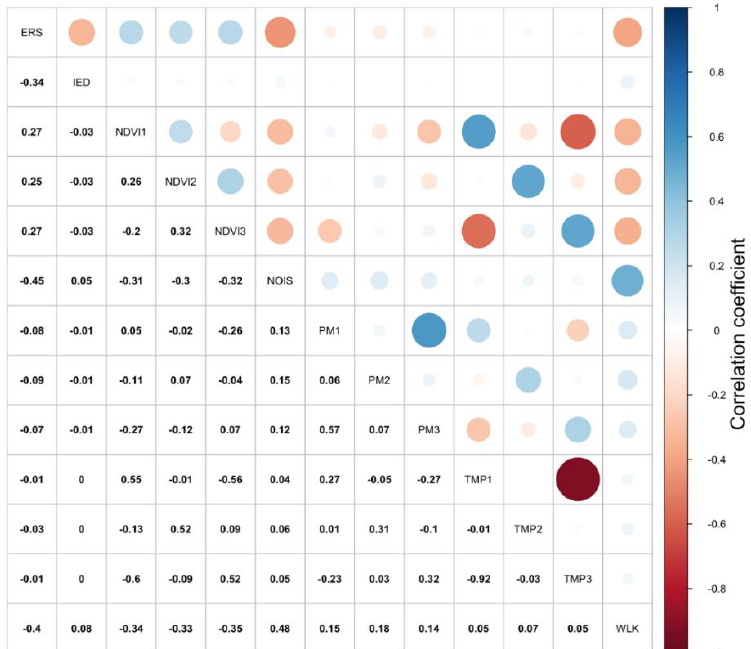
Figure 1. The correlations between the environmental exposures, the built environment characteristics, and the economic indices during pregnancy. Figure 1 shows the correlations between all the exposures. Higher positive correlations are marked with larger blue circles, and higher negative correlations are marked with larger red circles. ERS = economic residential segregation; IED = index of economic dissimilarity; NDVI 1 to 3 = normalized di ff erence vegetation index in the 1st, 2nd, and 3rd trimesters; PM 1 to 3 = fine particulate matter in the 1st, 2nd, and 3rd trimesters; TMP 1 to 3 = temperature in the 1st, 2nd, and 3rd trimesters. Table 3. The association between birthweight and each environmental exposure, built environment exposure, and economic indices during pregnancy in single, and multi-exposure models ( n = 640,695). IQR Difference in Weight (g per IQR Increase (95% CI)) Exposure Single Exposure Models